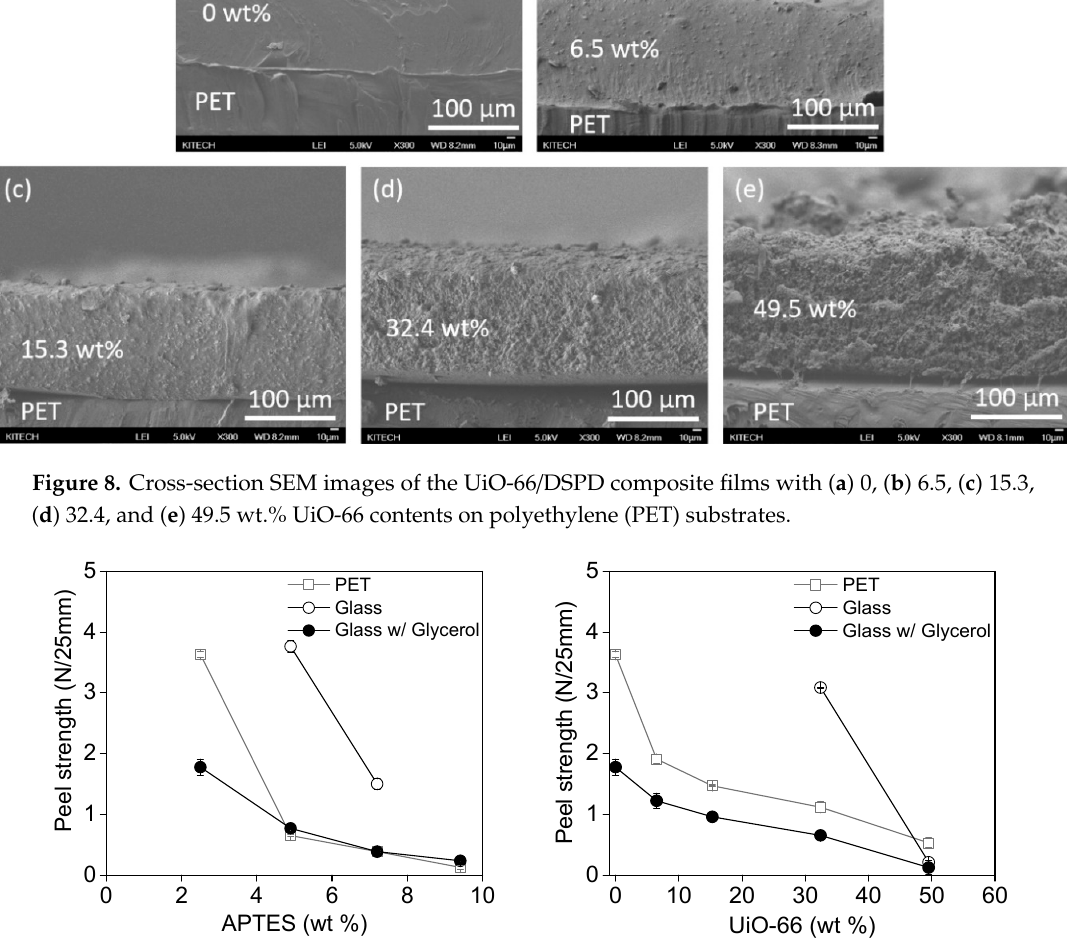
Figure 9. ( a ) Peel strengths of DSPD films with different amounts of silane and ( b ) DSPD composite films with different amounts of UiO-66 ( b ) on the PET or glass substrate. The silane content of composite films is 2.5 wt.%.